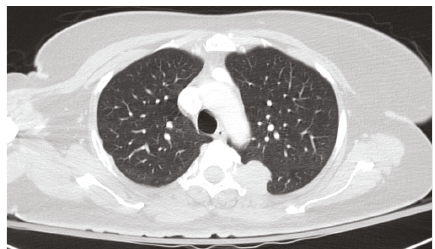
Figure 3: CT of the chest showing a subpleural mass in the upper left lobe that measured 3.3 × 3.0 × 2.7 cm concerning for metastasis.